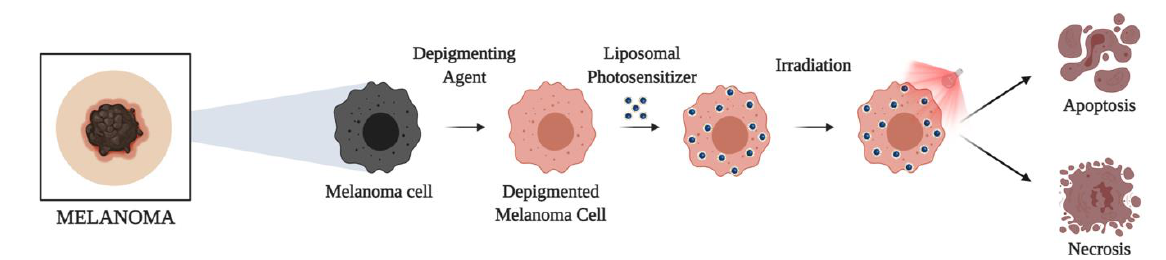
Figure 4. Enhanced photodynamic therapy combining neoadjuvant topical depigmentation and liposomal photosensitizing drug delivery to treat resistant melanotic melanoma.